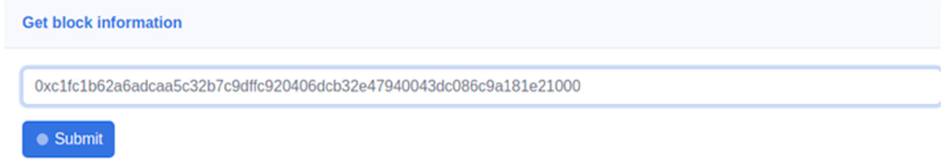
Figure 14. Access to Block details.